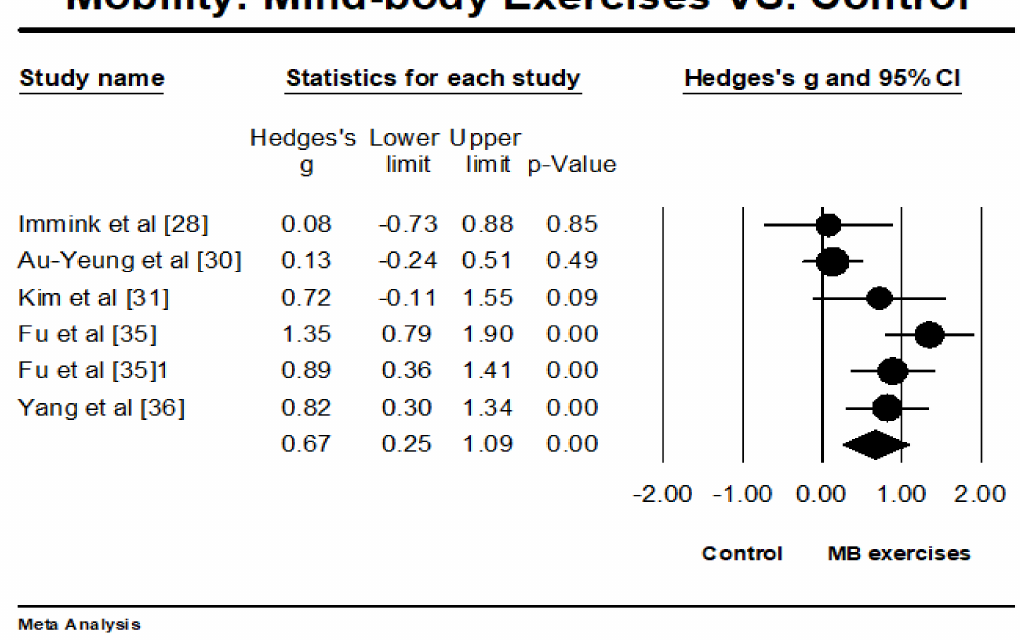
Figure 4. Effect of mind-body exercises on mobility function. (Circled symbol represents the effect size of each individual study and squared symbol represents an overall/pooled effect size of all studies on each